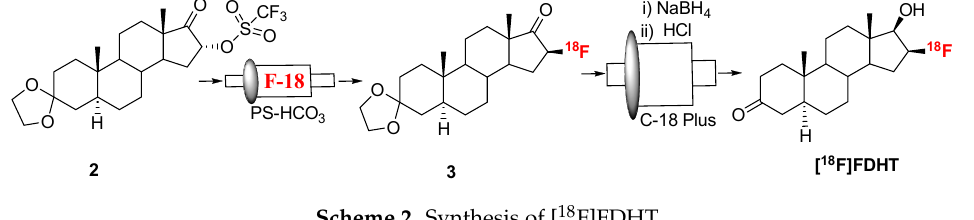
Table 2. Elution conditions from the Sep-Pak to prepare compound 3 , the intermediate for [ 18 F]FDHT. Compound